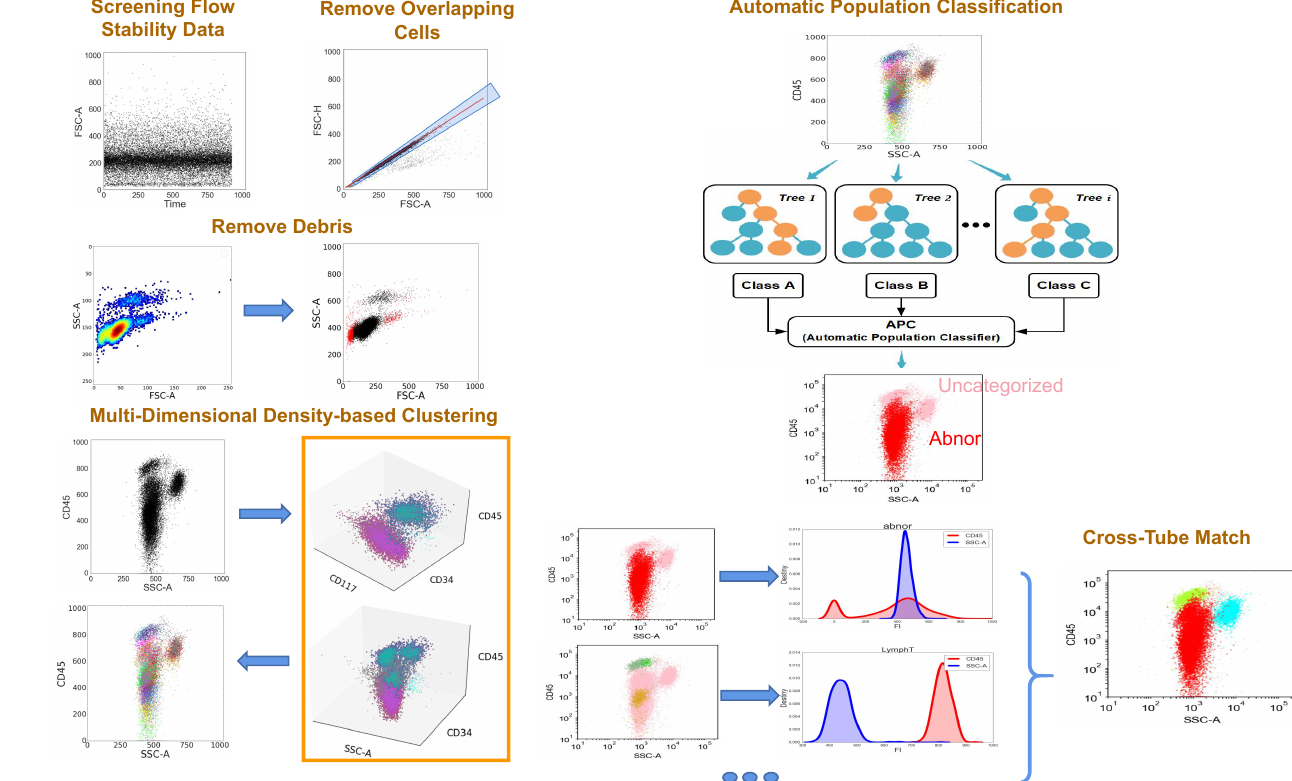
Figure 2. Output and visualization of the